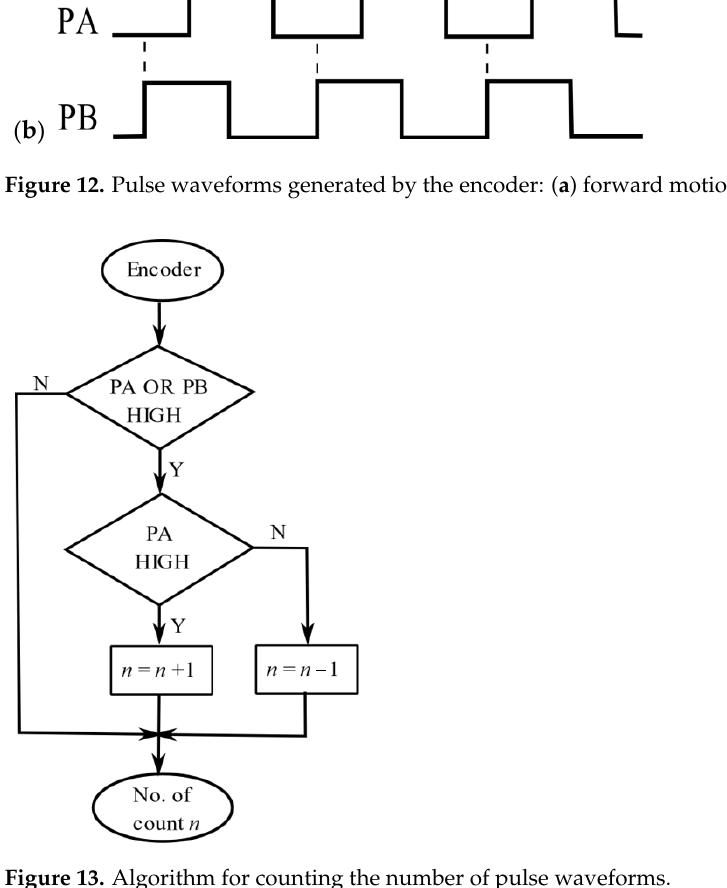
Figure 13. Algorithm for counting the number of pulse waveforms.